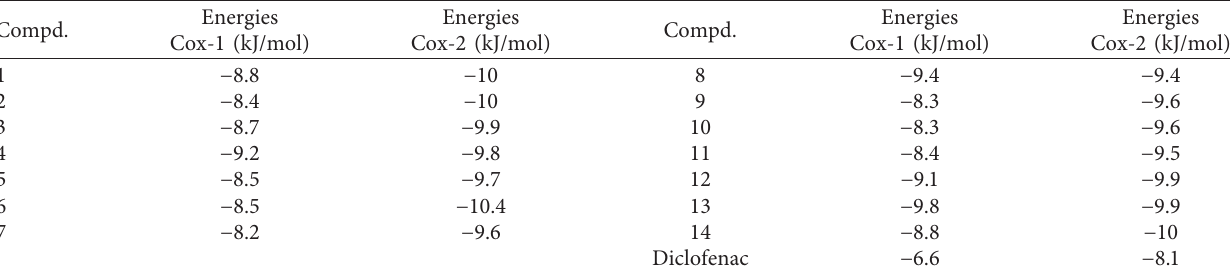
Figure 2: Binding of standard drug, diclofenac with COX-2 protein. (a) Representation of diclofenac binding with COX-2 in ball and stick form. (b) Representation of diclofenac binding with COX-2 in ball and space fill form. Table 6: Docking energies of the compounds with COX-1 and COX-2